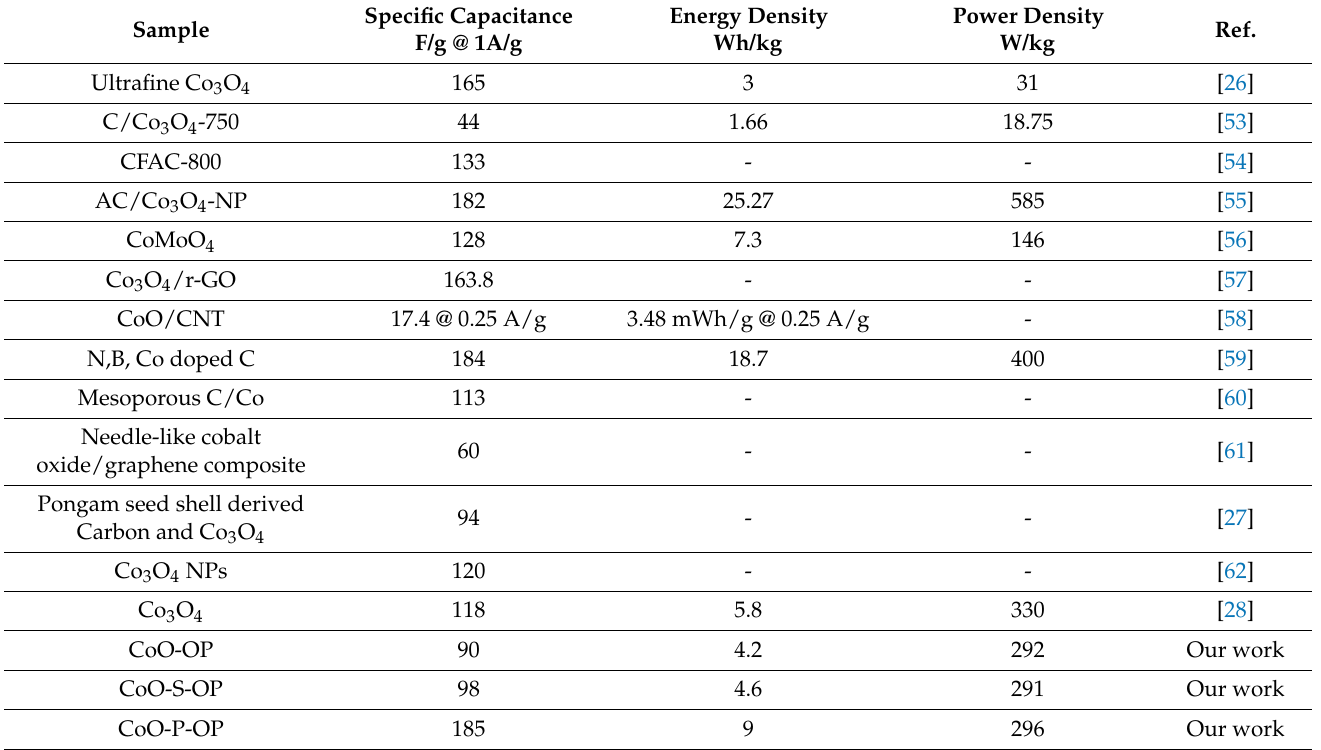
Table 2. The comparison of specific capacitance, energy density, and power density of our samples with other reported